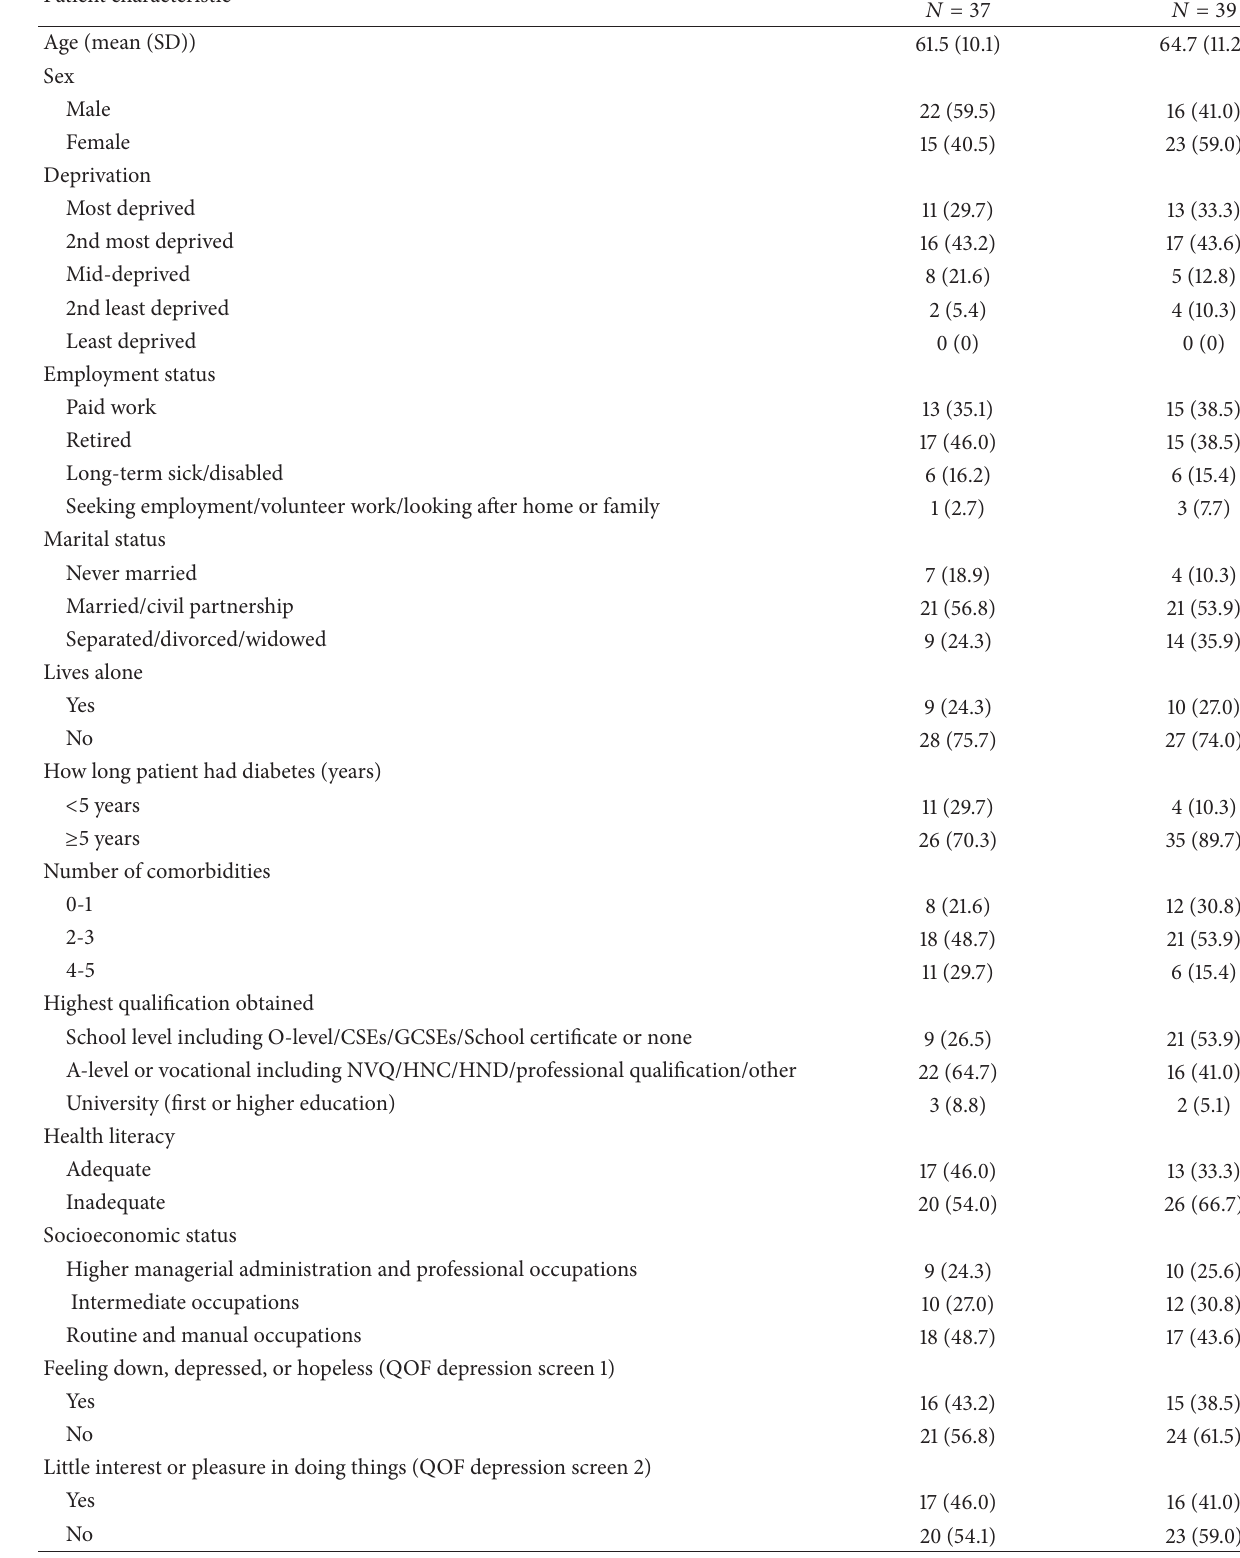
Table 1: Baseline patient characteristics between usual care and health